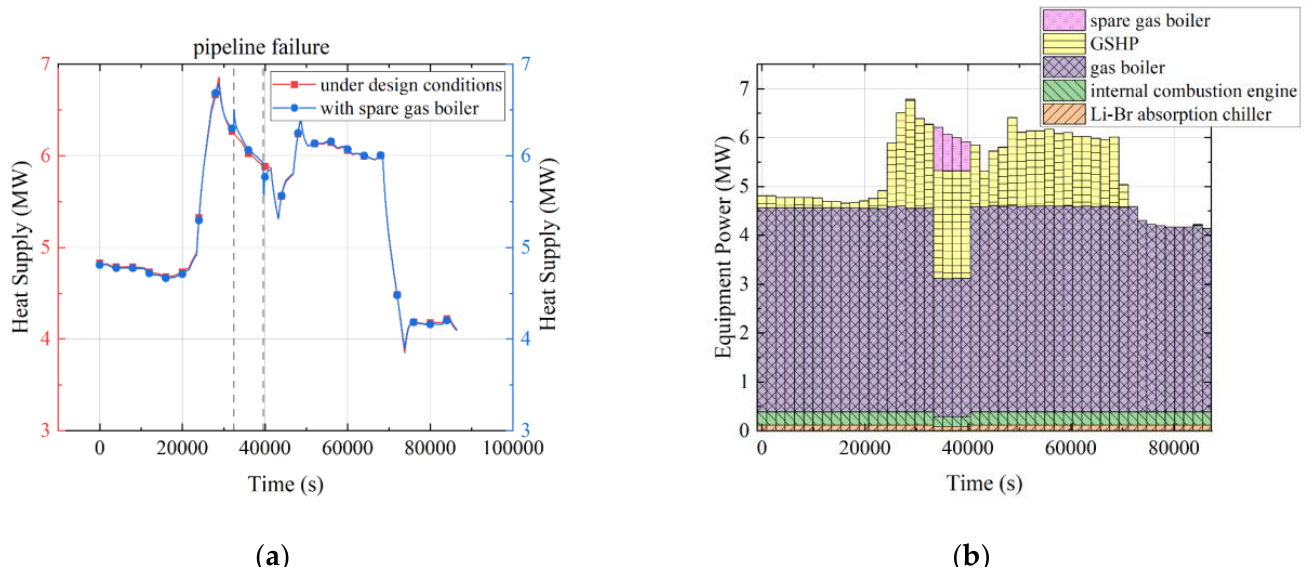
Figure 13. Dynamic response of IES with spare gas boiler method. ( a ) heat supply; ( b ) equipment power.